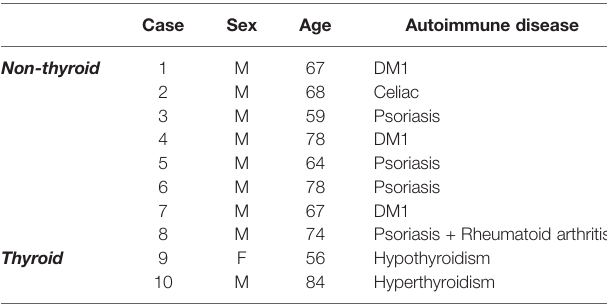
TABLE 1 | Demographics of bvFTD patients with autoimmune